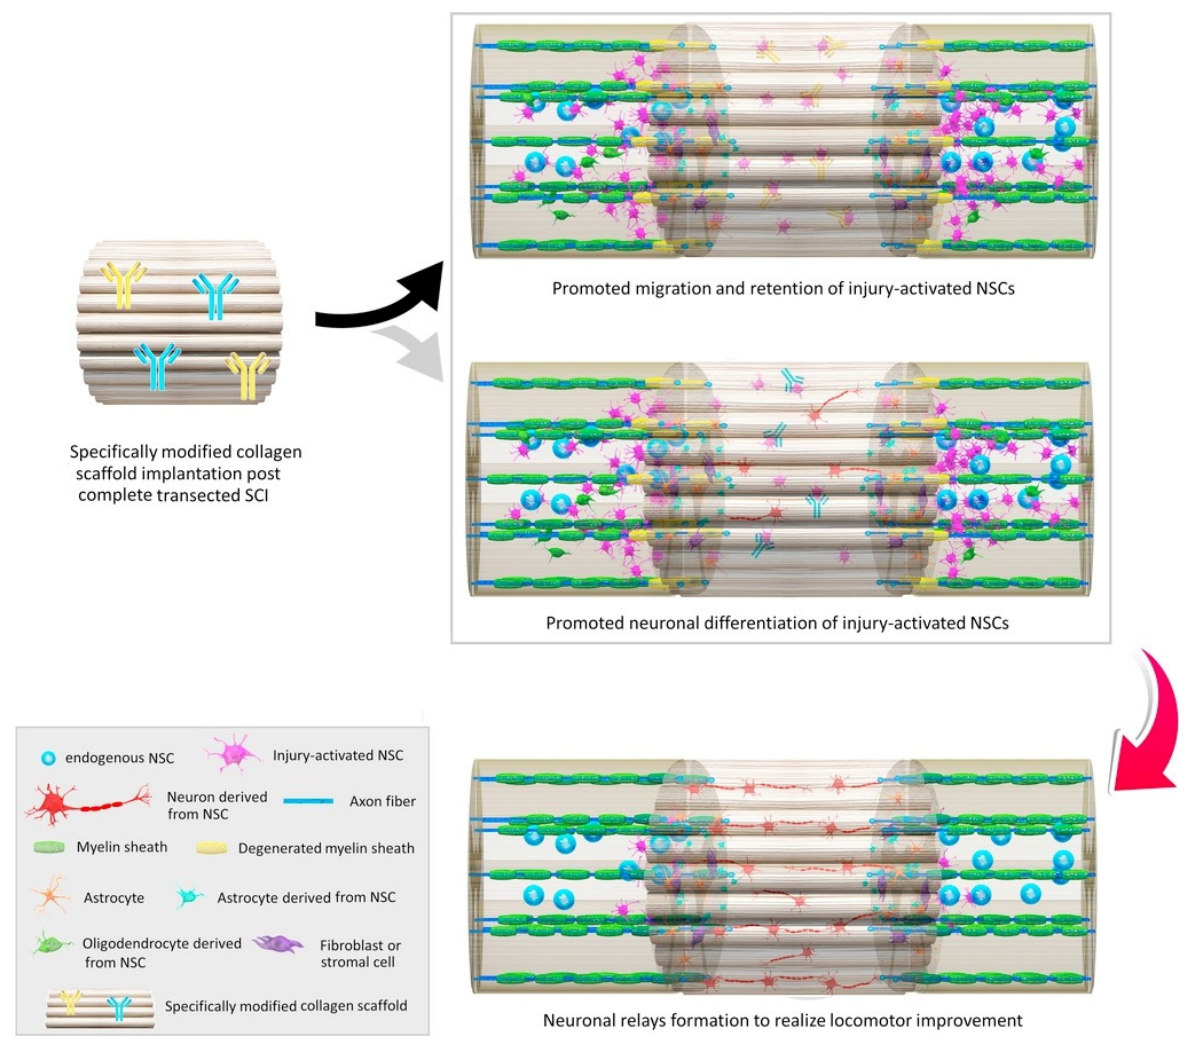
Figure 5. Schematic representation of in situ modulations of neuronal relay formation from injury-activated neural stem cells (NSCs) by implantation of functional bio-scaffolds in promoting locomotor outcome in animals after complete SCI. Reprinted from an open-access source [20].